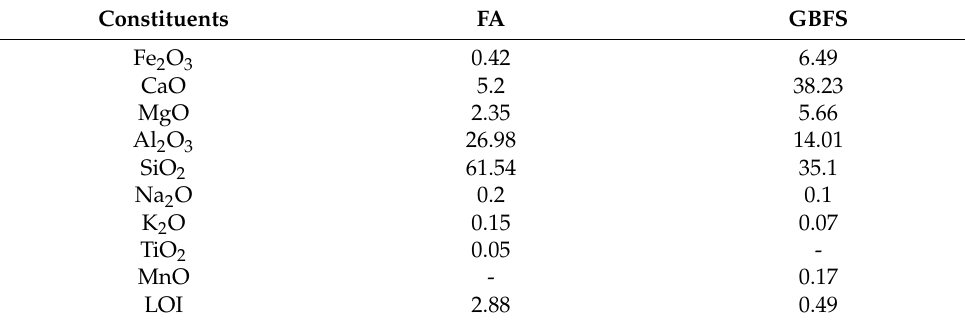
Table 2. Characteristics of PVA Fibres.